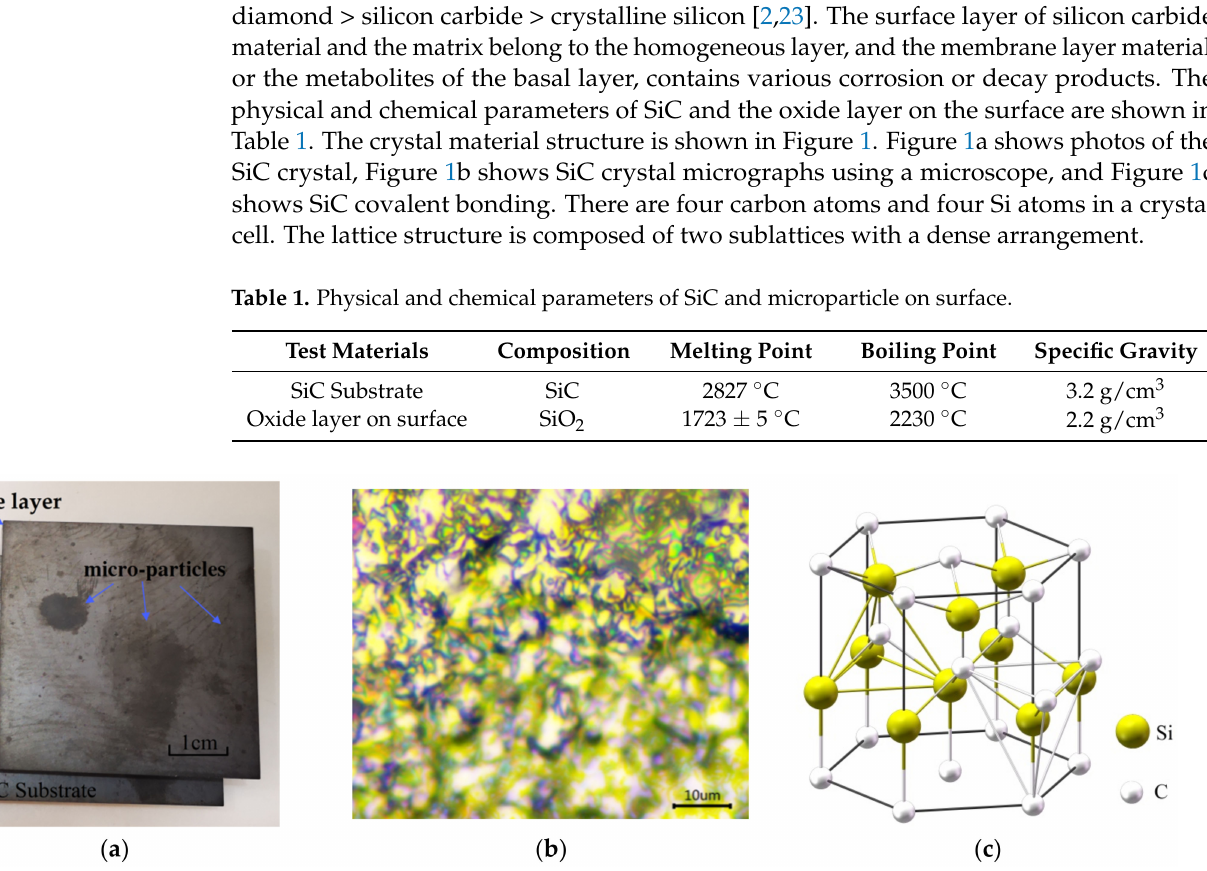
Figure 1. Structure of silicon carbide SiC (SiC) single-crystal material. ( a ) Photos of SiC crystal, ( b ) SiC crystal micrographs via microscope, ( c ) SiC covalent